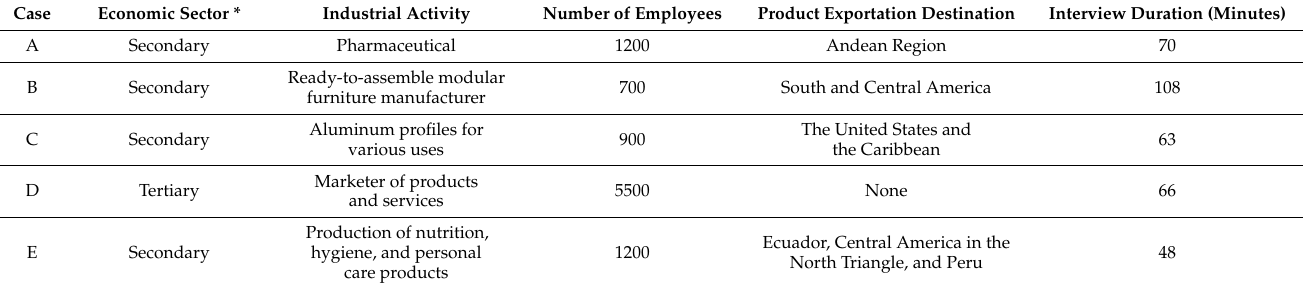
Table 2. Characteristics of the companies that participated in the case